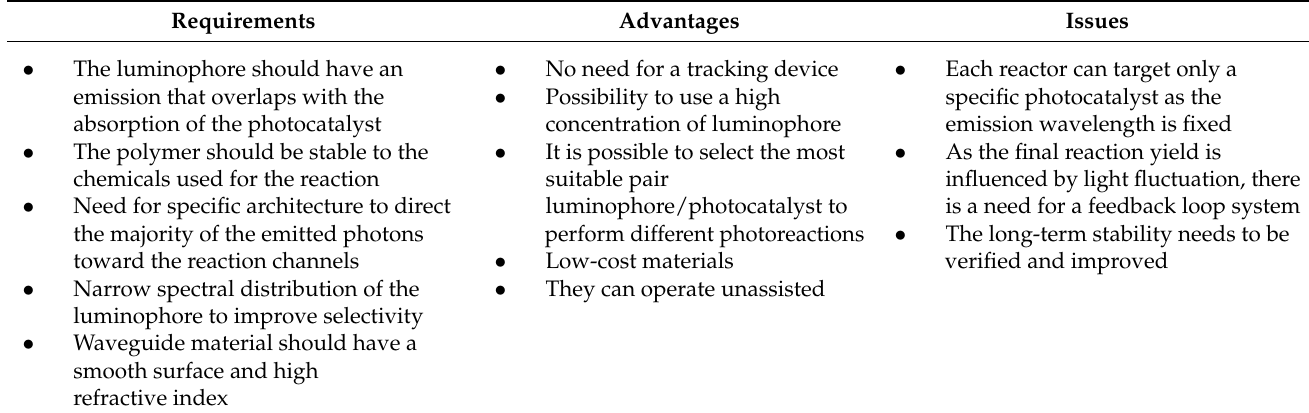
Table 1. Summary of the critical parameters of LSC-PM